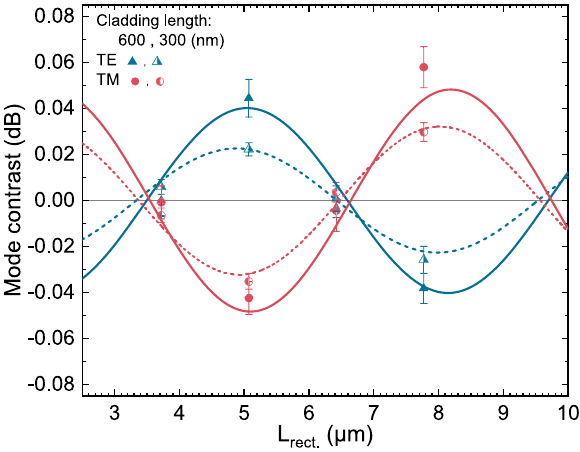
) obtained from TX . rect.